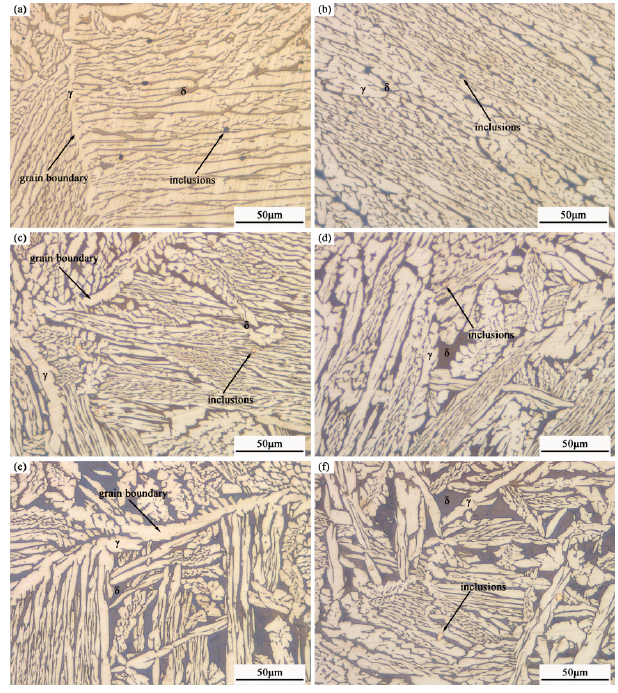
Figure 6. Microstructure of the three samples with high magnification: ( a , b ) S1; ( c , d ) S2; and ( e , f ) S3 (online version in color). Metals 2020 , 10 , x FOR PEER REVIEW